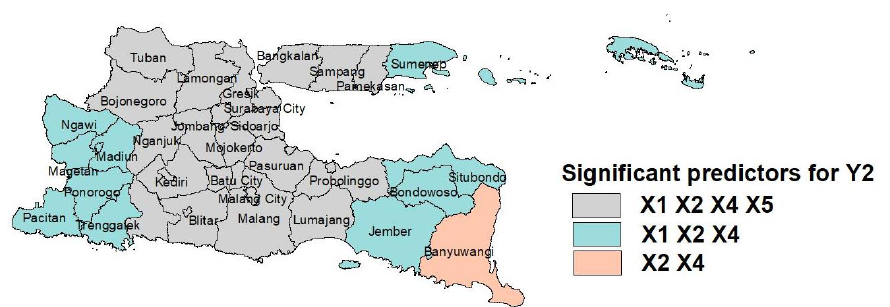
Figure 6. Regional group based on factors that influence the number of under-5 deaths in East Java in 2019.